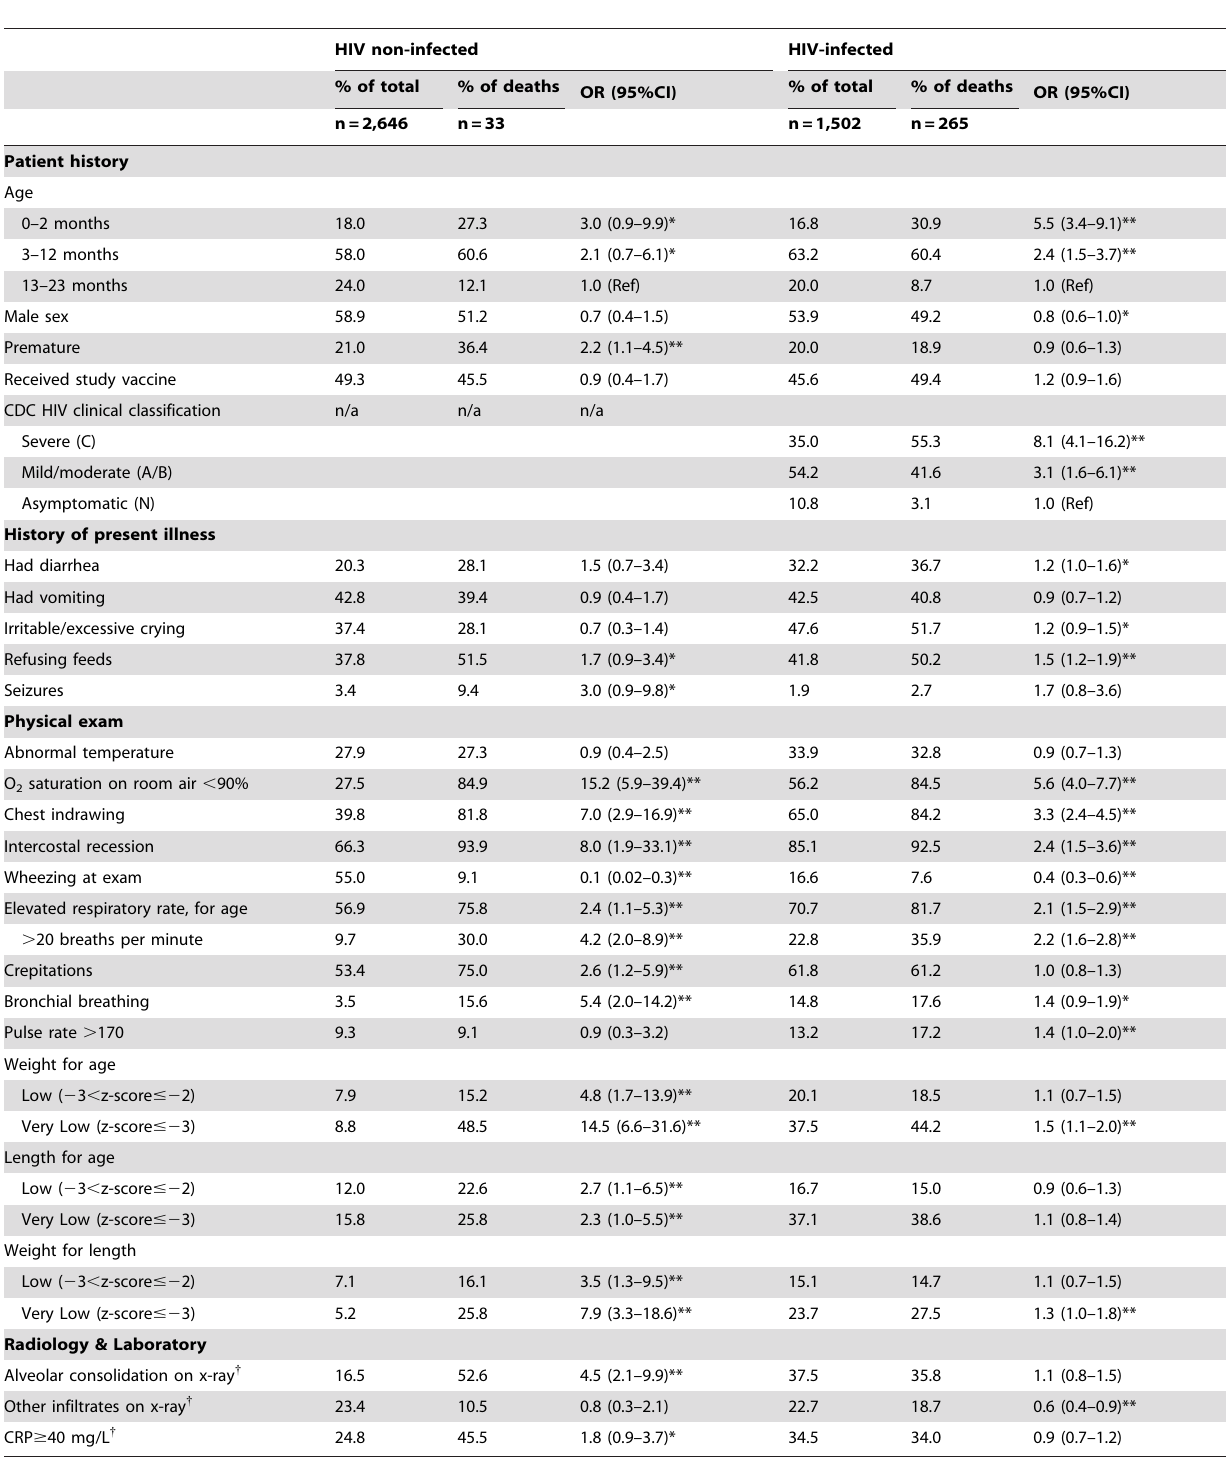
Table 1. Description and univariate analysis of risk factors for mortality among HIV non-infected and HIV-infected children , 24 months of age hospitalized with